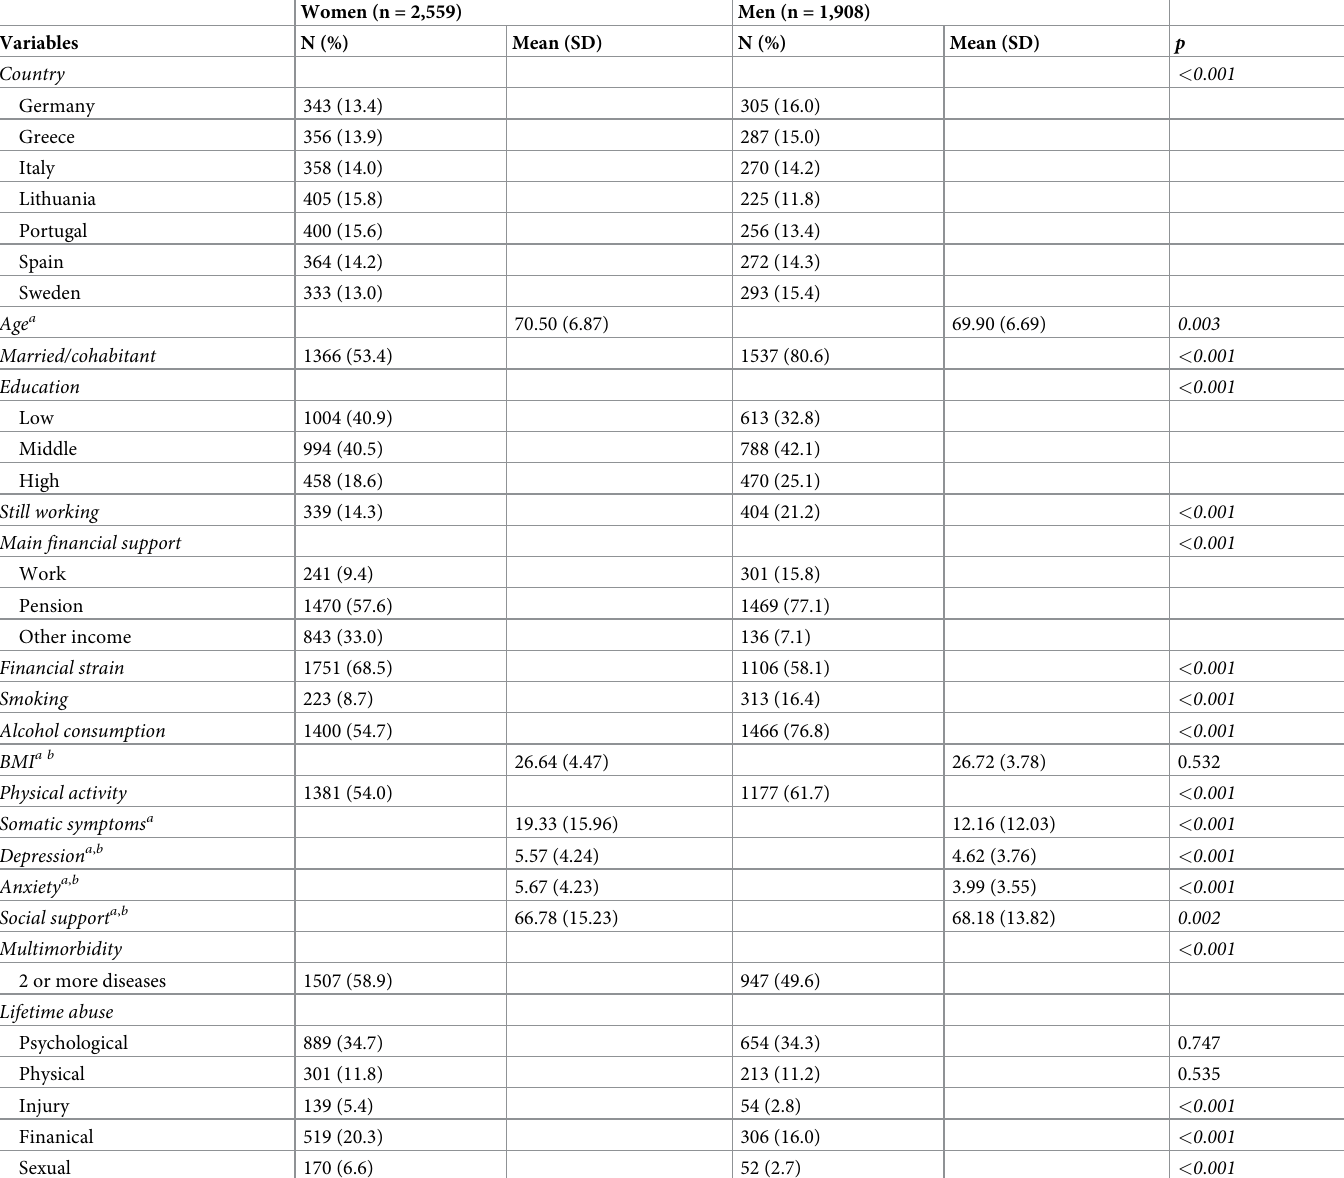
Table 1. Demographic/socio-economic variables and lifetime abuse among women and